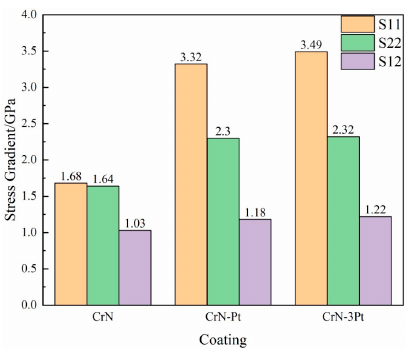
Figure 5. Isotropic stress gradients on the surfaces of three coatings.